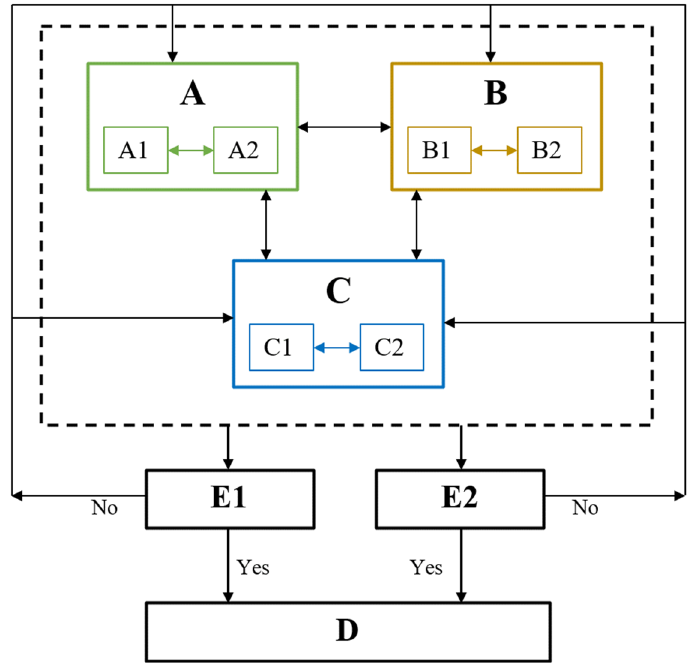
Figure 1. The algorithm for managerial actions on the rational use of renewable sources of energy: A—the block where the source of the renewable energy is chosen; A1—the analysis of the types of renewable sources of energy; A2—making decisions on using certain types of renewable sources of energy; B—the block of the potential of the source of the renewable energy; B1—the analysis of the factors that affect the potential of the renewable sources of energy; B2—the evaluation and making decisions on the available potential of the source of the renewable energy; C—the block of choosing the methods of obtaining or consuming the renewable energy; C1—the analysis of the factors that affect the efficiency of the renewable energy production and use; C2—making decisions on the method of renewable energy production and use; E1—energy independence, the economic effect; E2—environmental friendliness, food security, social effect; D—total effect (making a decision on the renewable energy production or use).